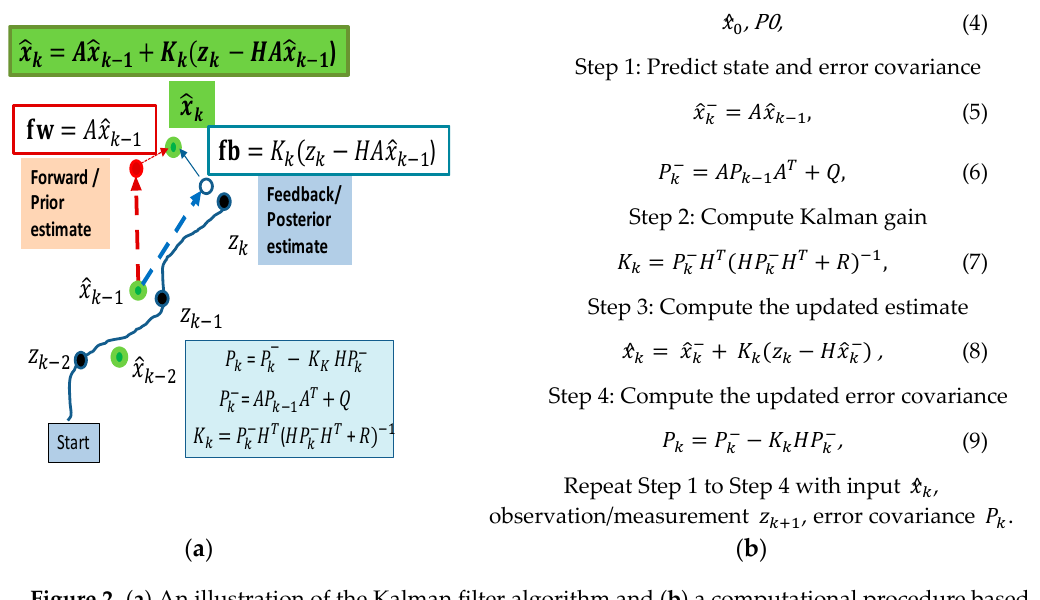
(cid:1) (cid:0) z k − H ˆ x − ), which is weighted by Kalman gain k k